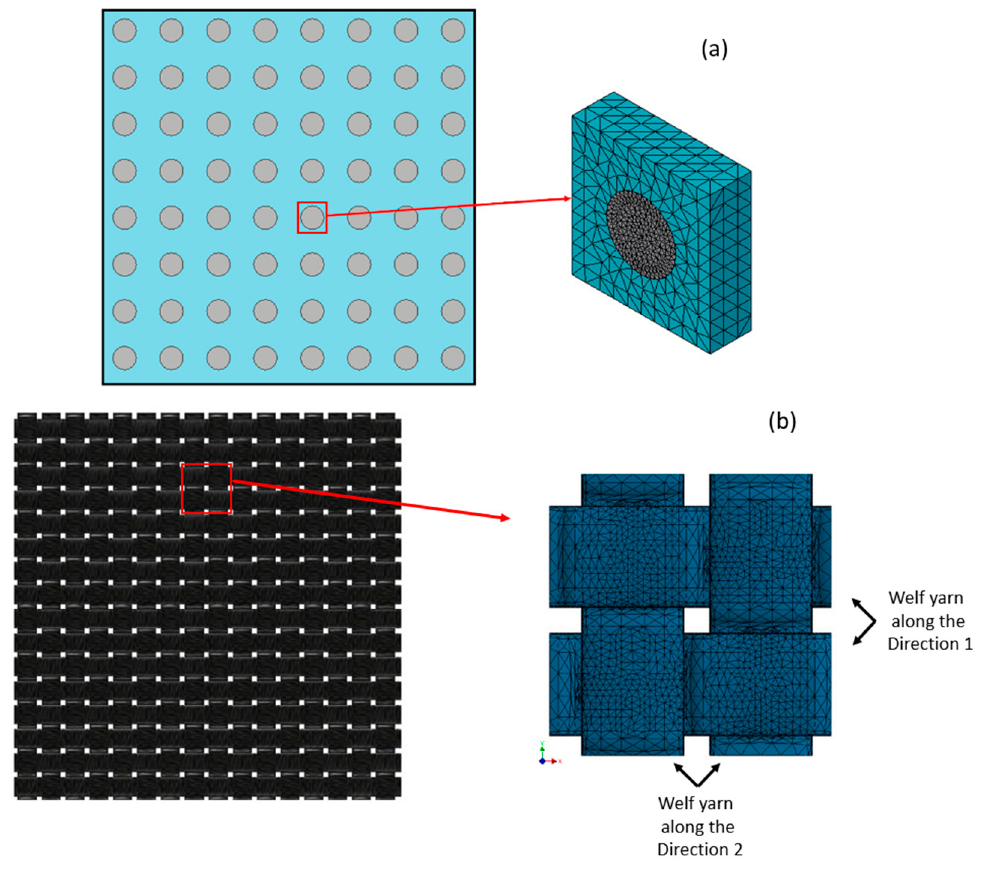
Figure 8. ( a ) Square arrangement of the microscale unit cell and ( b ) mesoscale, macroscopic unit cell.